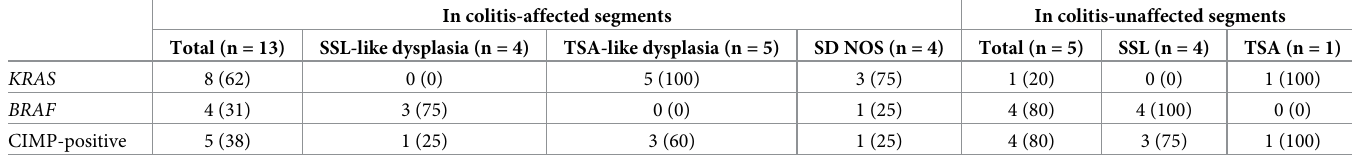
Table 4. Genetic and epigenetic analyses of serrated polyps in patients with ulcerative colitis. In colitis-affected segments In colitis-unaffected segments Total (n = 13) SSL-like dysplasia (n = 4) TSA-like dysplasia (n = 5) SD NOS (n = 4) Total (n = 5)